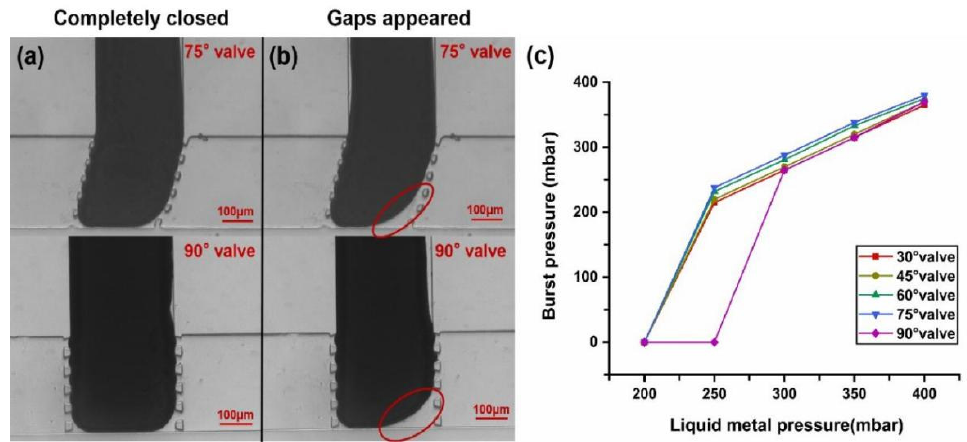
Figure 7. Morphological changes of microvalves at burst pressure and burst pressure values under different conditions. ( a ) The microvalves were completely closed. ( b ) Partial gaps appeared in the microvalves. ( c ) Burst pressure curve for the microvalves of different angles.